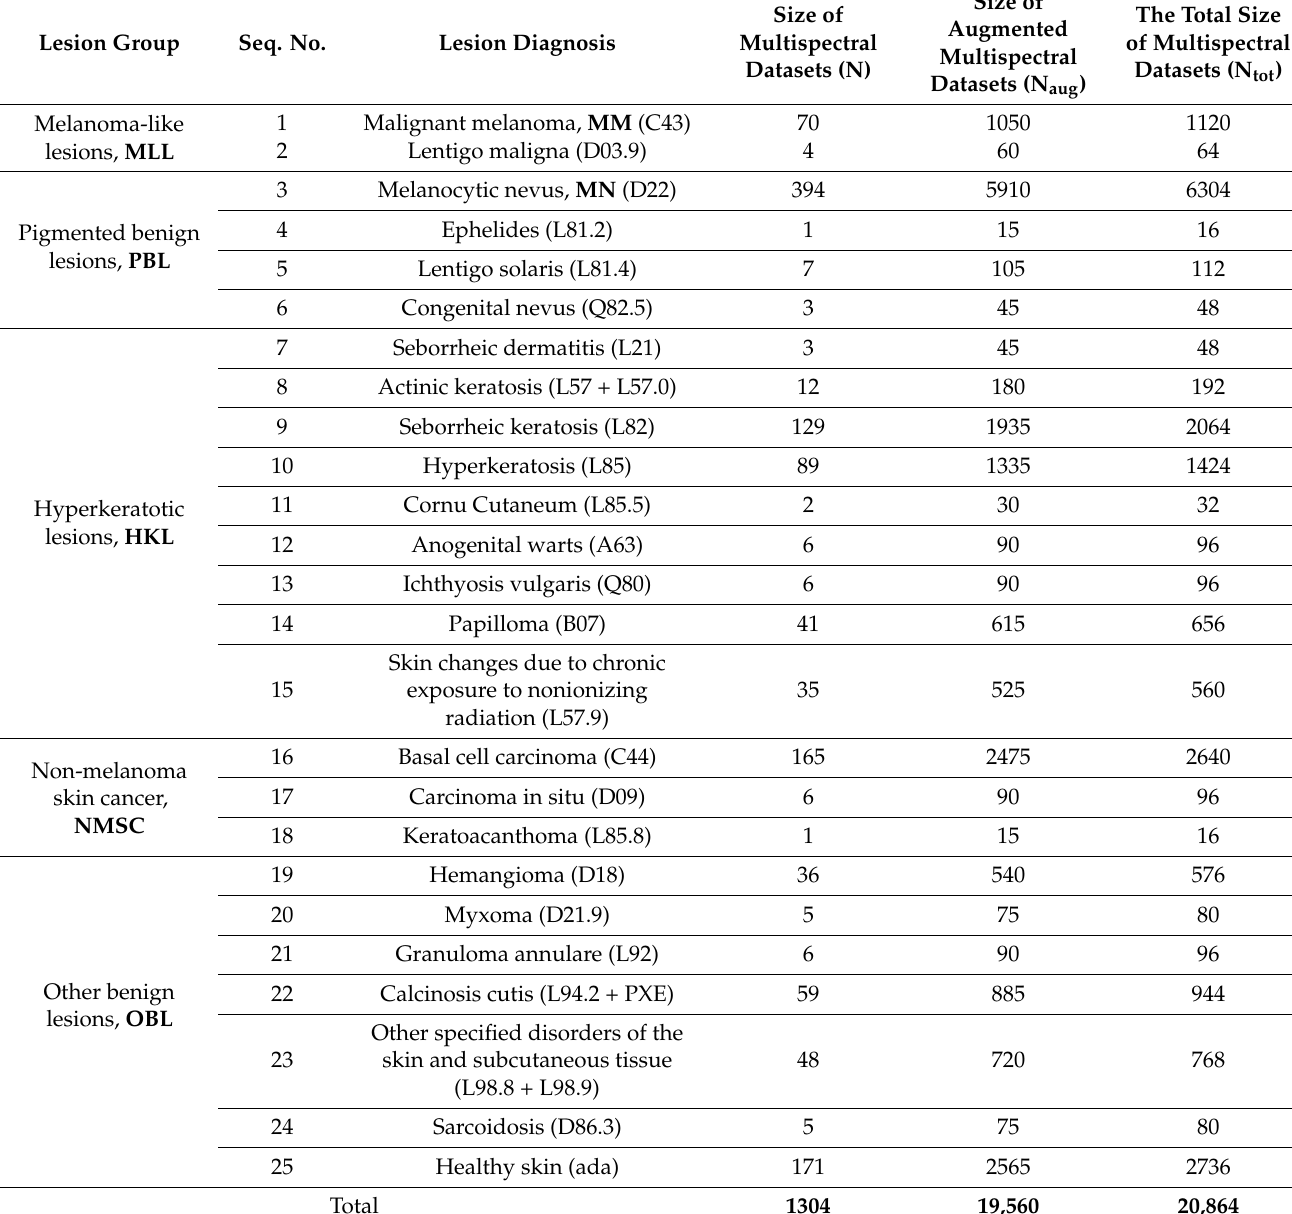
Table 1. Distribution of skin lesion groups and the size of multispectral image